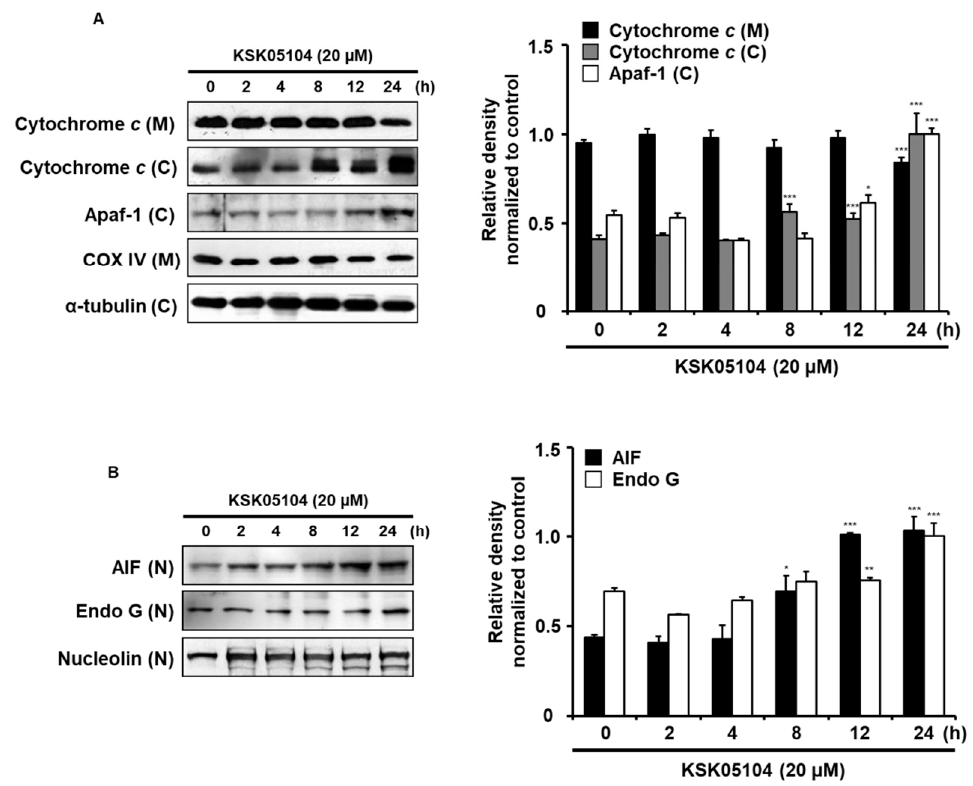
Figure 5. Effect of KSK05104 on the translocation of mitochondrial apoptotic factors in HT-29 cells. ( A , B ) The cells were treated with 20 µ M KSK05104 for 24 h and then harvested. Mitochondrial (M), cytosolic (C), and nuclear (N) fractions and total cell lysates were prepared. Expression of Cyt c , Apaf-1, apoptosis inducing factor (AIF), and Endo G were examined via Western blot analysis. COX IV, α -tubulin and nucleolin were used as internal controls and data are presented by results from three independent experiments. Ratio of relative density was determined by a densitometric analysis program (Bio-rad Quantity One ® Software) normalized to internal control. * p < 0.05, ** p < 0.01, *** p < 0.001 vs. non-treated control group.